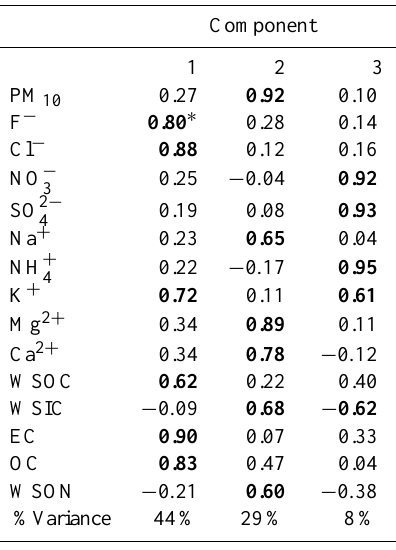
Table 3. Principal component analysis for PM 10 of Xi’an during the whole sampling period ( N =